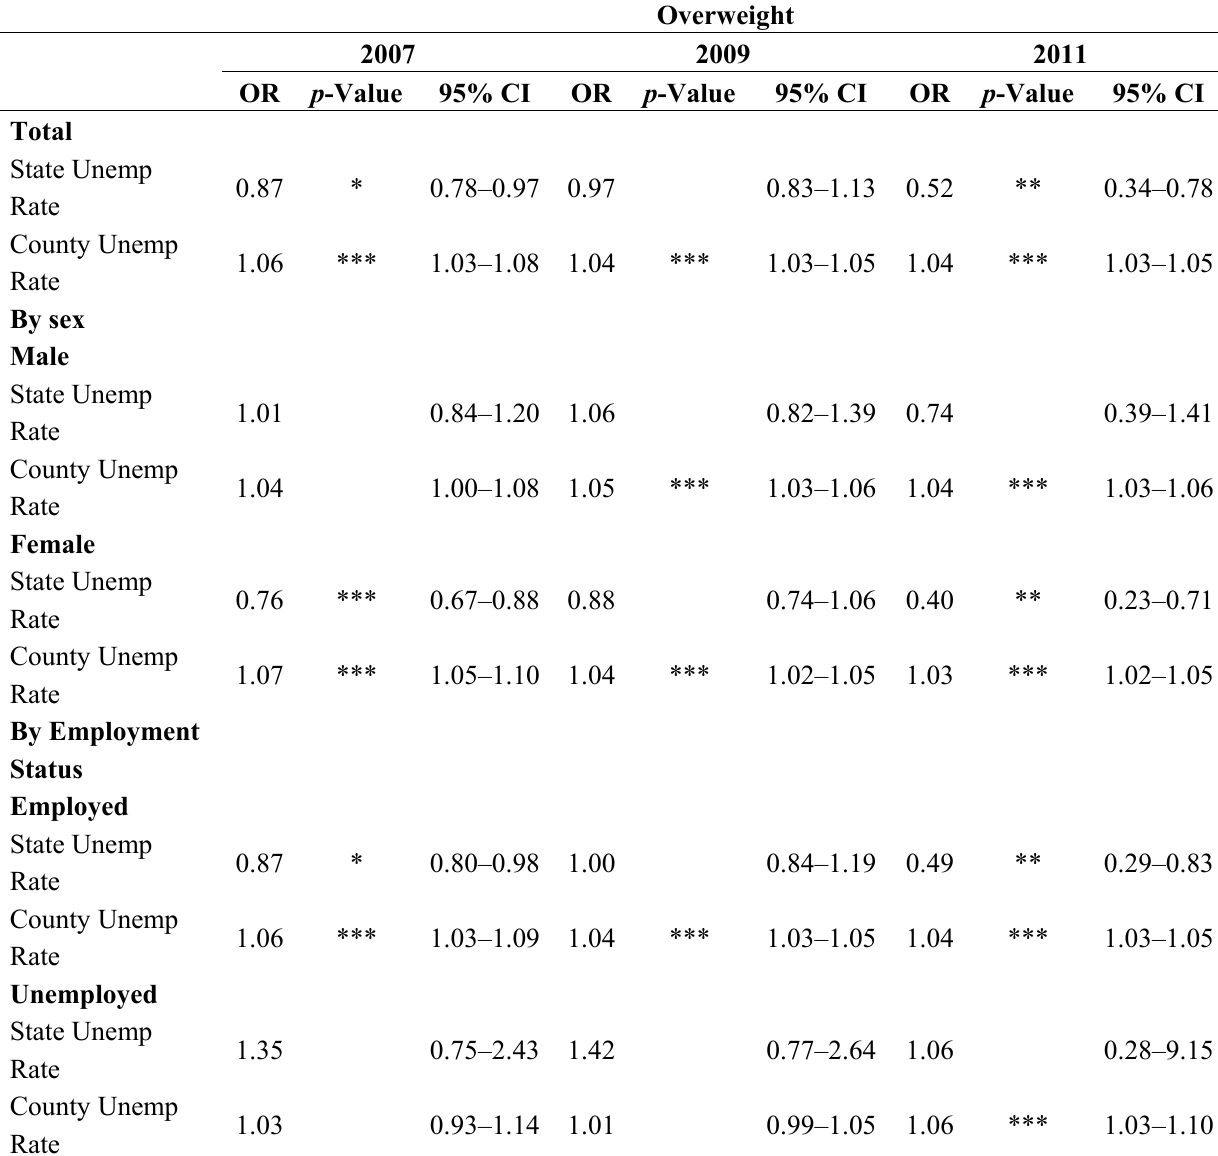
Table 3. Individual risk of overweight among BRFSS participants in 2007, 2009 and 2011 by state and county unemployment